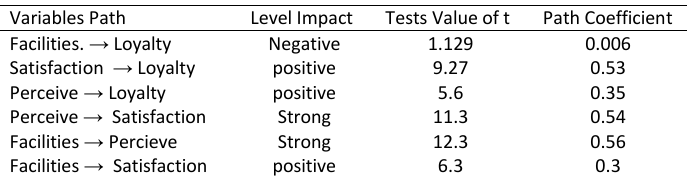
Table 3: Summarizes the Results of Hypotheses Test